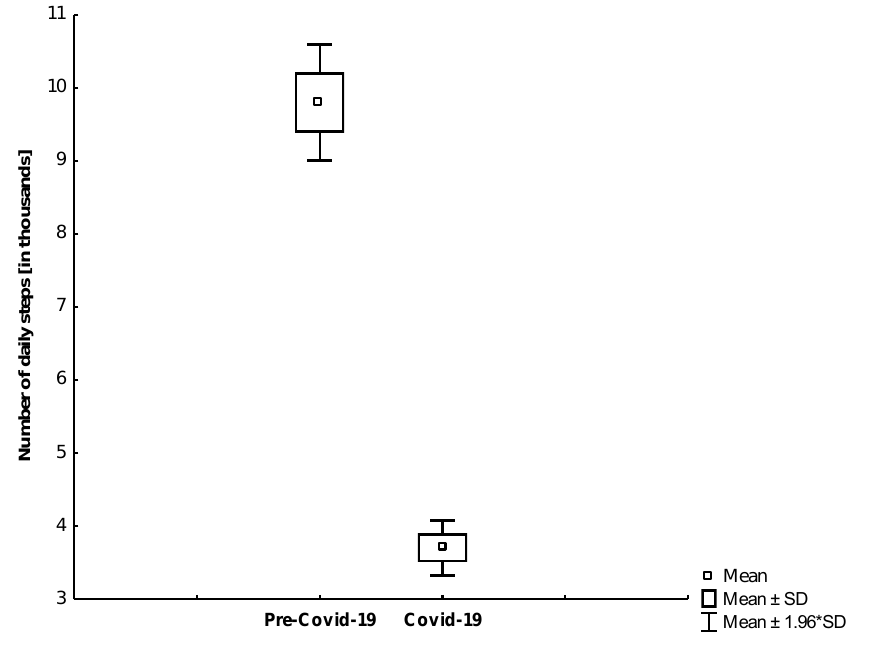
Figure 3. The comparison of the number of daily steps in the analyzed periods among young participants ( p < 0.001).